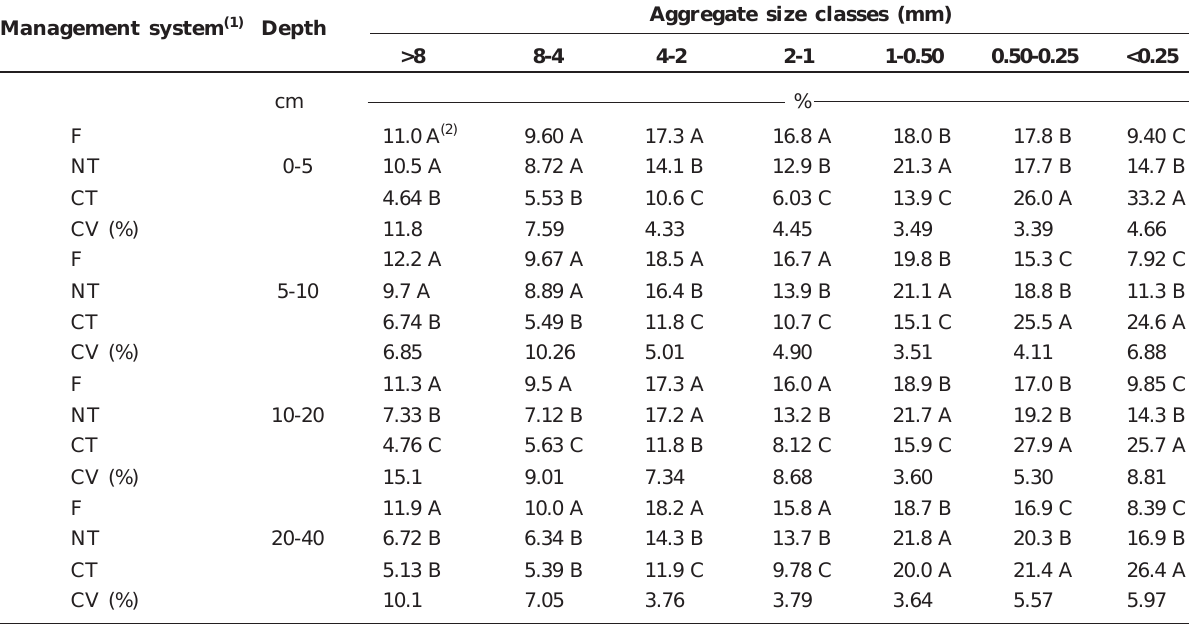
Table 3. Distribution of aggregate size classes as a function of management system and soil depth